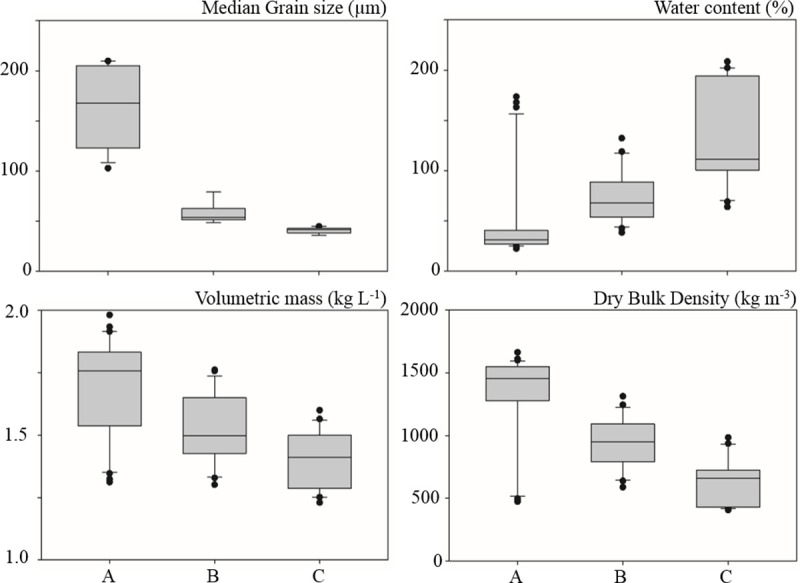
Boxplot of sedimentary parameters as a function of sediment type.Three classes were distinguished in both months: A. Sandy sites (% fine < 40%), B. Sand-mud mixture (%fine range between 40 and 60%) and C. Muddy sites (% fine > 60%).